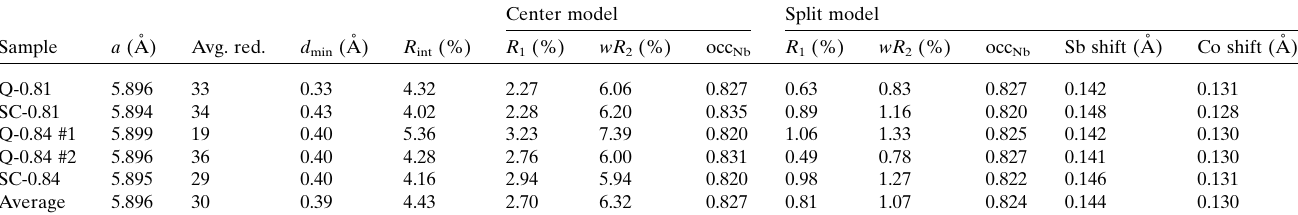
Table 1 Average structure refinements for the different Nb 1 (cid:2) x CoSb